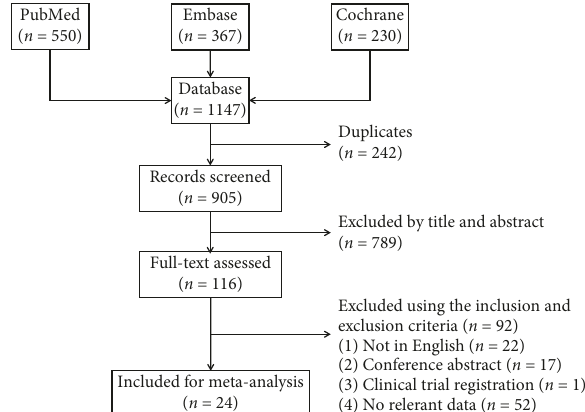
Figure 1: Flow diagram of the inclusion of studies in this meta- analysis.